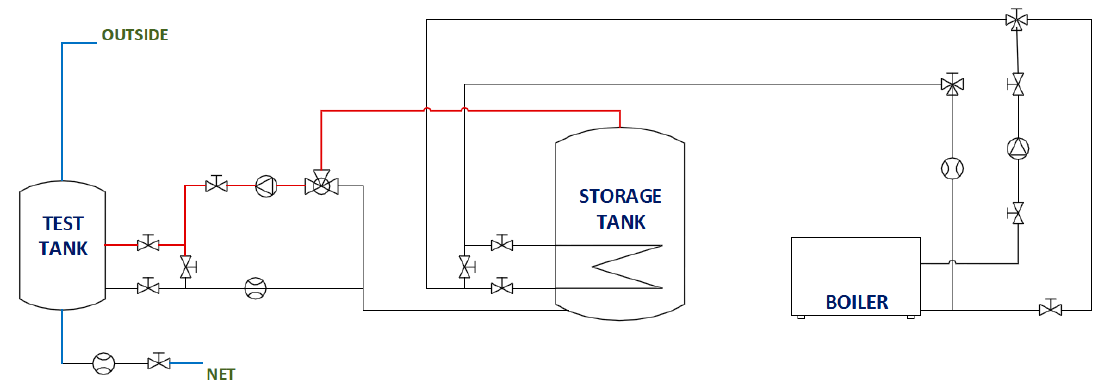
Figure 3. Diagram of the installation.